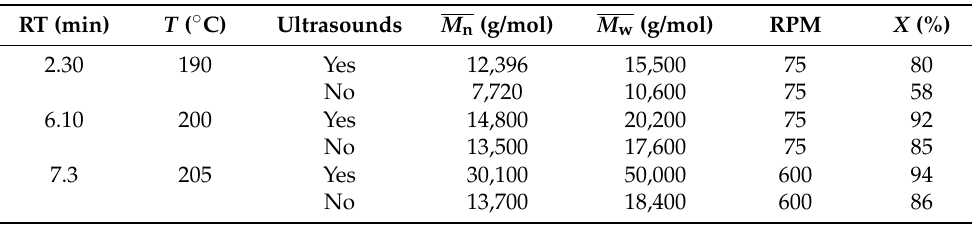
Table 2. Reactive extrusion experimental